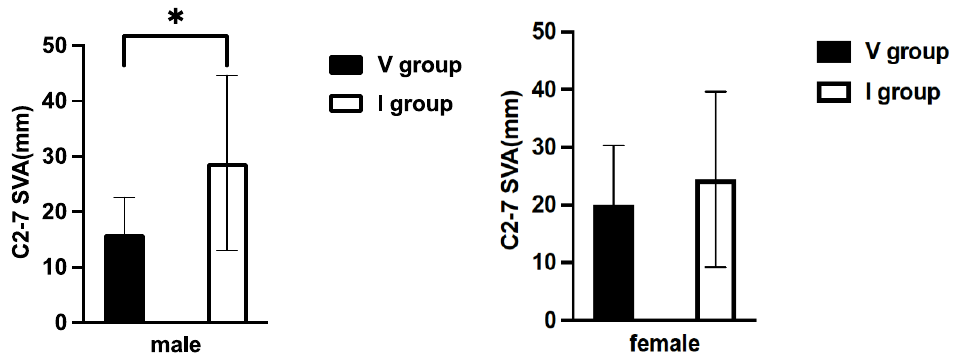
Figure 2. Comparison of the C2-7 SVA between the I and V groups in males and females. *: p < 0.05; V group: T1 slope visible; I group: T1 slope invisible; C2-7 SVA, C2-7 sagittal vertical axis. In the neutral position, the mean C2-7 angle in males was 11.8° in the V group, and 12.1° in the I group, and the mean C2-7 angle in females was 11.0° and 10.4° in the V and